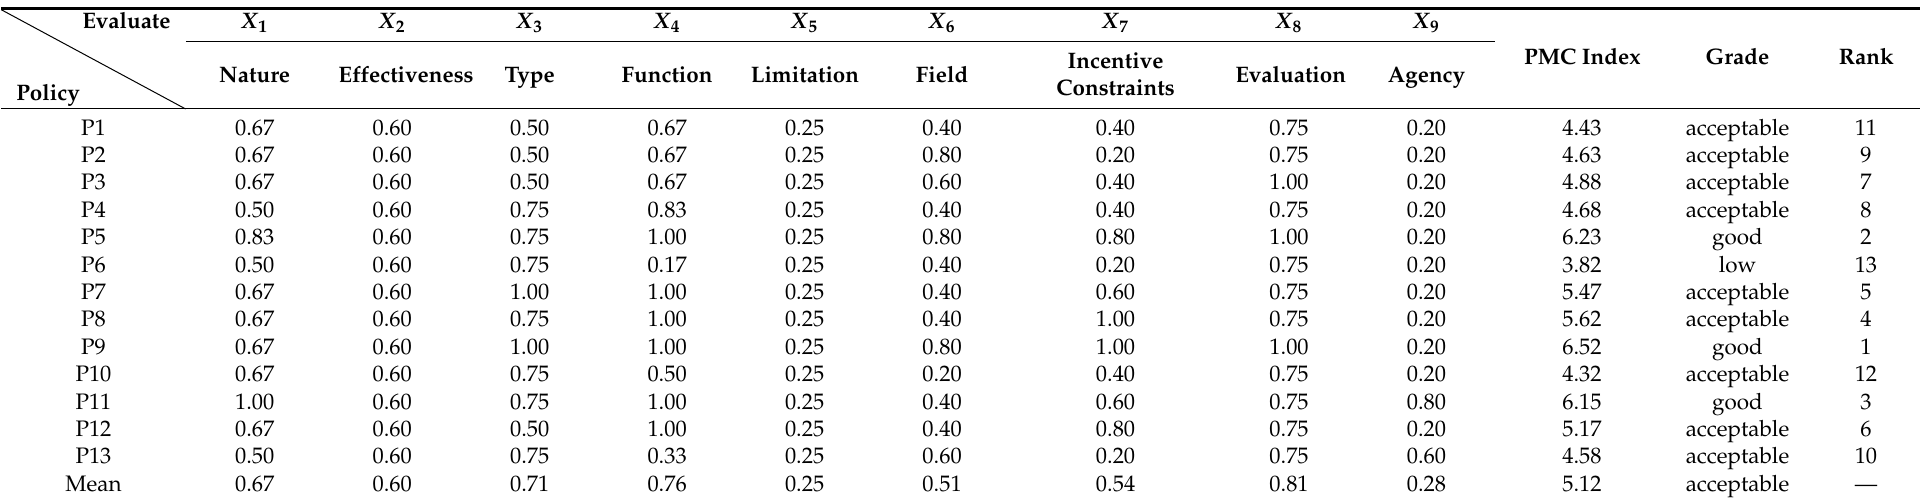
Table 4. Results of quantitative evaluation of fishery insurance policy based on PMC